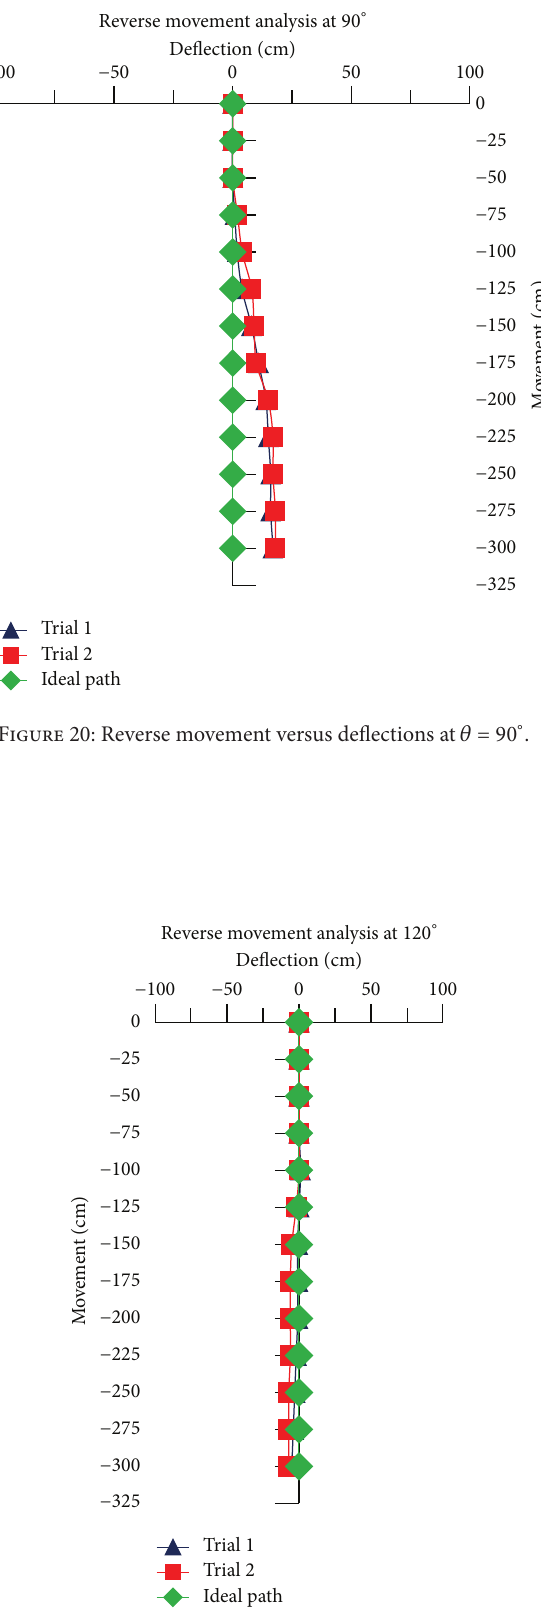
Figure 21: Reverse movement versus deflections at 𝜃 = 120 ∘